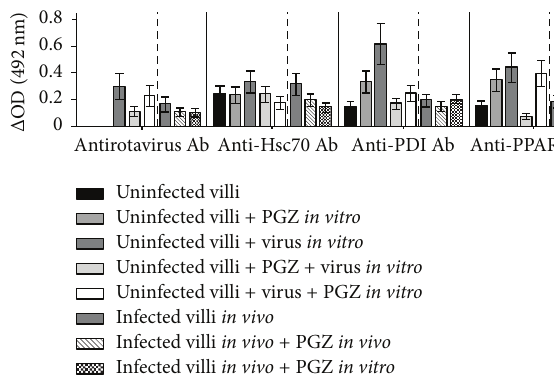
Figure 4: Effect of in vitro PGZ treatment on the expression of cellular proteins in villi isolated from in vivo ECwt-infected mice. Villi were isolated from ECwt-infected and noninfected mice ( 𝑛 = 3 per experiment) and then treated or not in vitro with PGZ. Villi were lysed and analyzed by ELISA using antibodies against rotavirus structural proteins (SP) and the indicated cellular proteins. Data are presented as mean ± SD from three independent experiments performed in